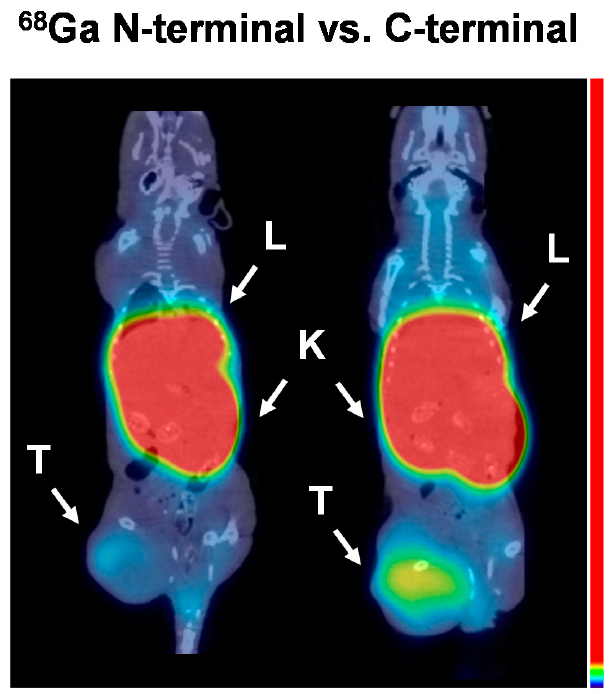
Figure 6. Positron Emission Tomography/Computed Tomography (microPET/CT) imaging of EpCAM expression in Balb/c nu/nu mice bearing EpCAM-expressing DU145 xenografts at 3 h post injection (p.i.) of DARPin Ec1 variants labeled with [ 68 Ga]Ga at N- or C-terminus. Arrows indicate: T—tumor, K—kidneys, L—liver. The same color scale (adjusted to the first red pixel in the tumor in the right image) was applied for both imaging. Lower SUV threshold 0.0, upper SUV threshold 1.0. Table 5. Comparative biodistribution of DARPin Ec1 variants labeled with [ 57 Co]Co, [ 68 Ga]Ga, [ 111 In]In and [ 125 I]I-HPEM at N- or C-terminus 3 h post injection (p.i.) in Balb/c nu/nu mice bearing EpCAM-expressing DU145 xenografts. Uptake is presented as % injected dose (ID)/g (average from 4 mice ± standard deviation (SD); from 7 mice ± SD for the [ 57 Co]Co C group). Data for intestines with content and carcass are presented as % ID per whole sample. One-way ANOVA with Bonferroni’s multiple comparisons test was performed to find significant differences between Ec1 variants with the same label position (N- or C-terminus).